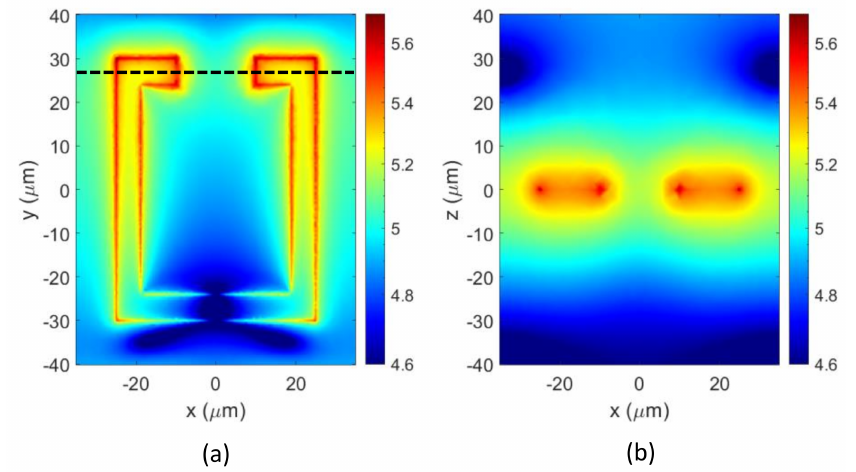
Figure 9. Near-field distributions of simulated polyimide-coated SRR deposited with an LC layer with a thickness of 310 µ m in ( a ) top and ( b ) cross-section